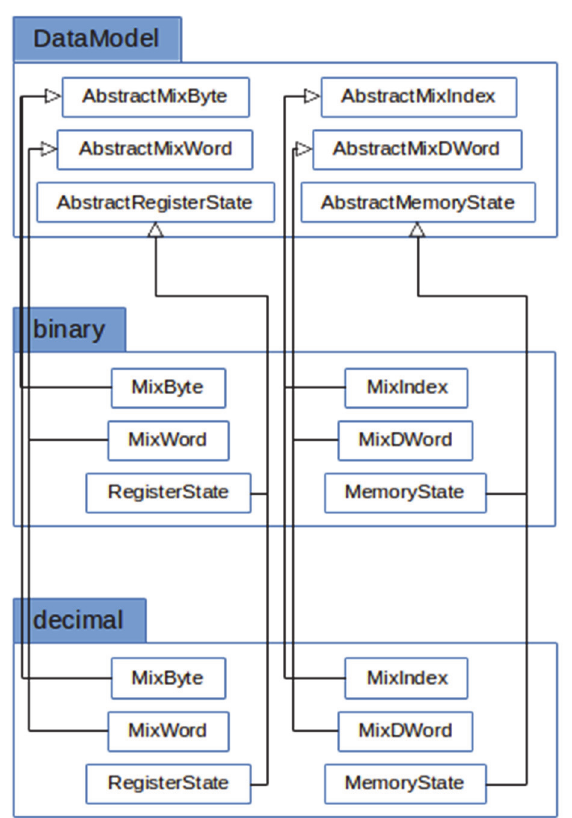
Fig. 2. Relationships between abstract and concrete data